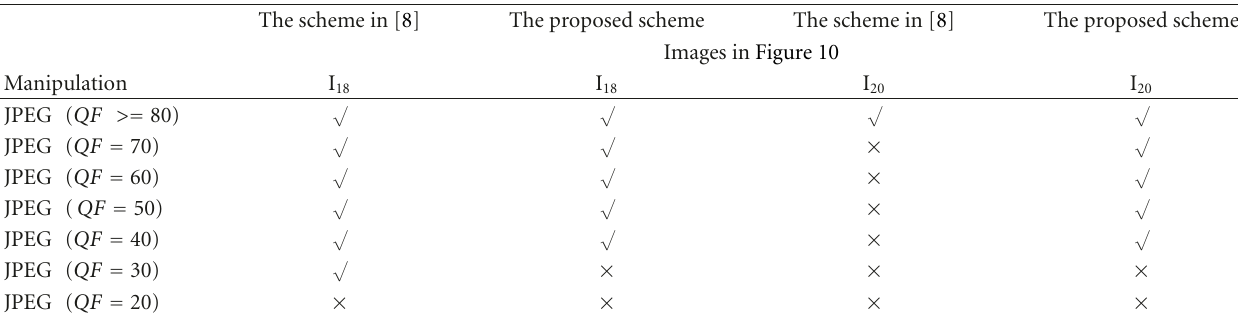
Table 6: Comparison with the scheme in [8] on images I 18 and I 20 in Figure 10.